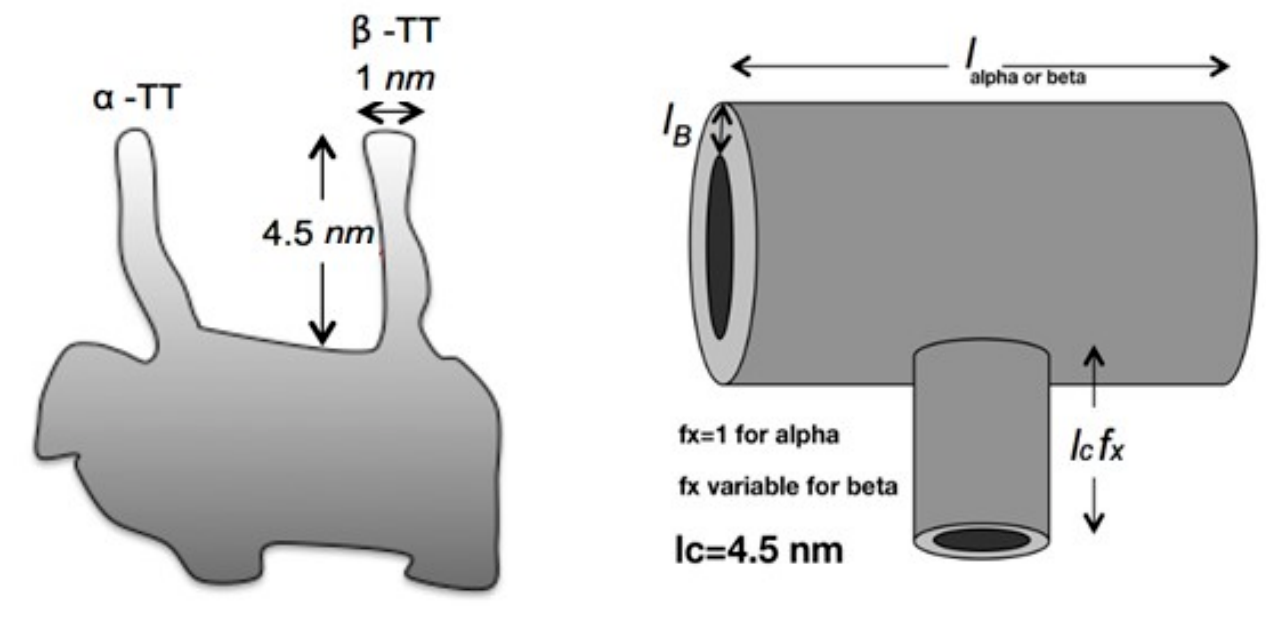
Figure 2. A sketch showing tubulin monomer physical model.